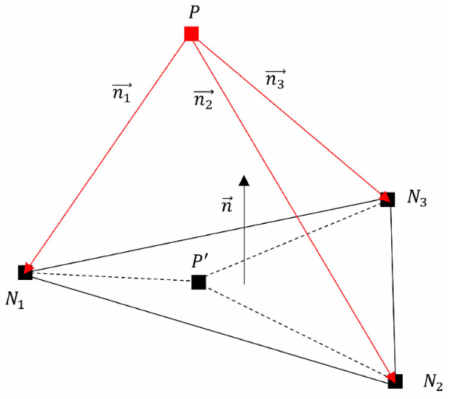
Figure 5. Project node P onto shell